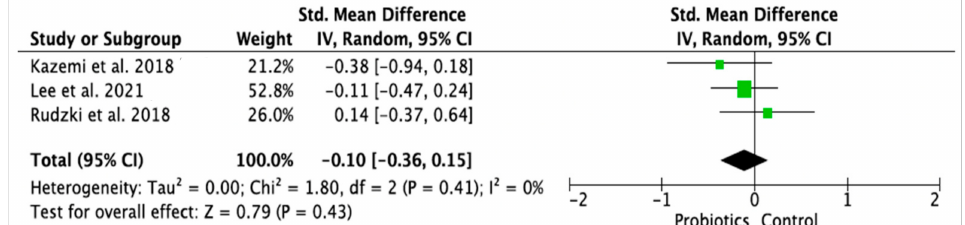
Figure 11. Forest plot for the effect of probiotic treatment on cortisol levels in probiotics and control groups [14,21,28]. Note: The green squares are the SMD for the post-hoc studies, the black rhombus is the graphical summary for all studies